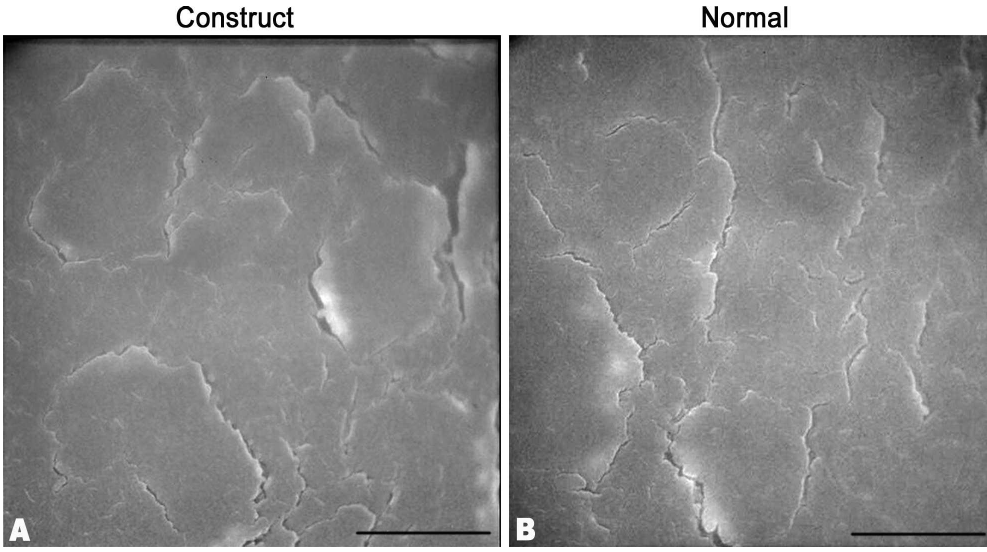
Fig 5. Ultrastructure of the epithelial cells of implanted cornea and normal cornea. The regenerated corneal epithelialcells on the implantsurface showed a similar morphology to that of natural corneal epithelialcells. Scale bar: 10 μ